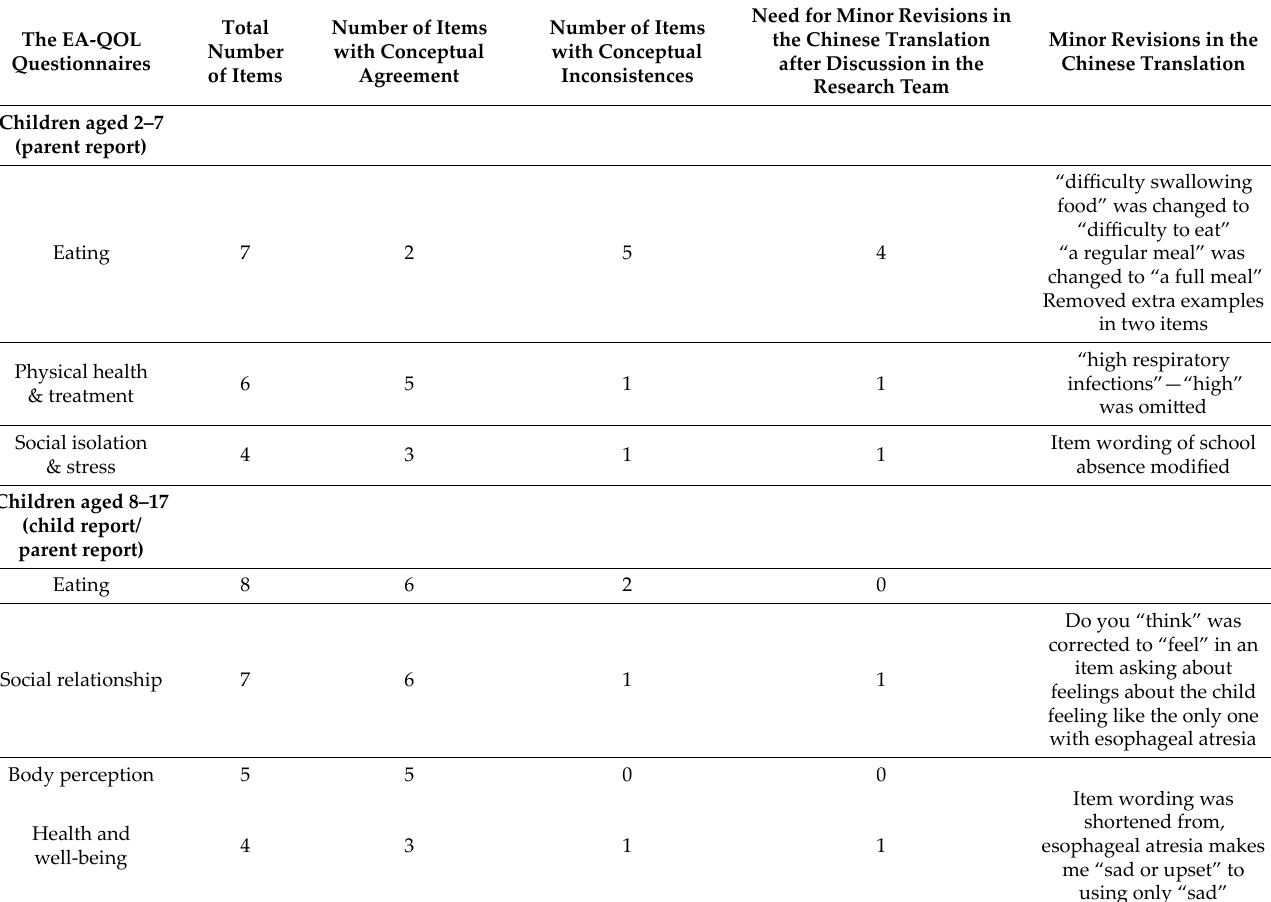
Table 2. An overview of the backtranslation review, including comparison of the back‑translation from Chinese Mandarin into US English, the original US English version and the Swedish version of the EA‑QOL questionnaires for children with esophageal